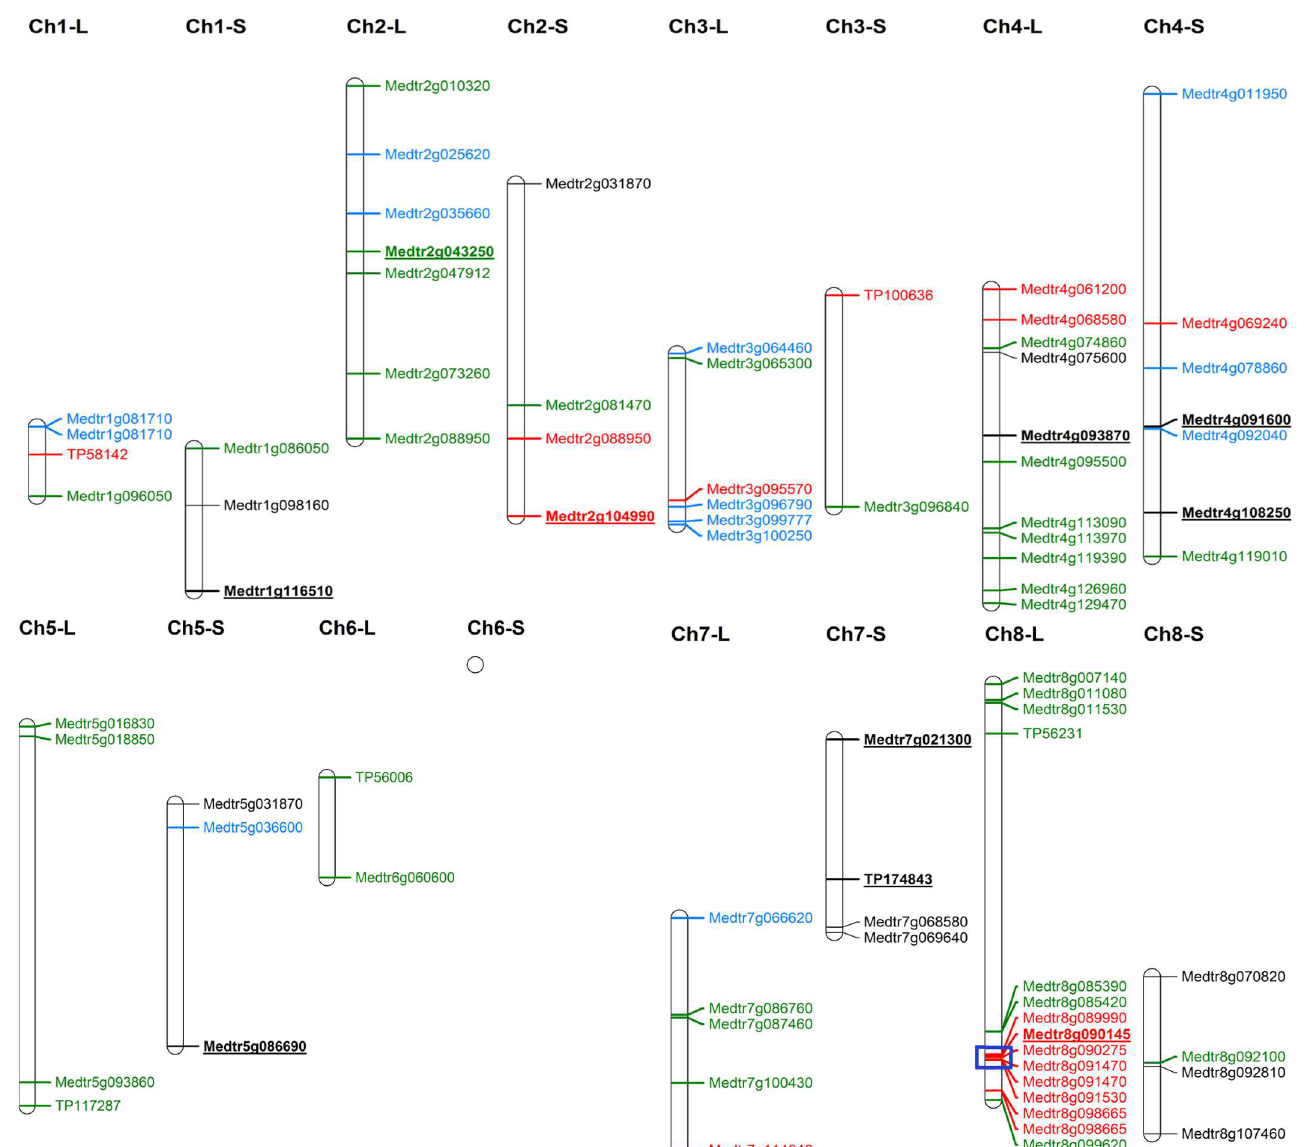
Fig 2. Physical map of annotated genes and markersassociated with alfalfa leaf (L) and stem (S) quality traits. Blue, neutral detergentfiber; red, acid detergent lignin; black, crude protein; green, in vitro NDF digestibilityat 24 hours. Major associations(whose definition is given in Table 3) are bold underlined. The blue box highlightsa portion of chromosome8 with high concentration of significantassociations. Marker positions were basedon the reference genomeof M . truncatula Mt4 . 0v1